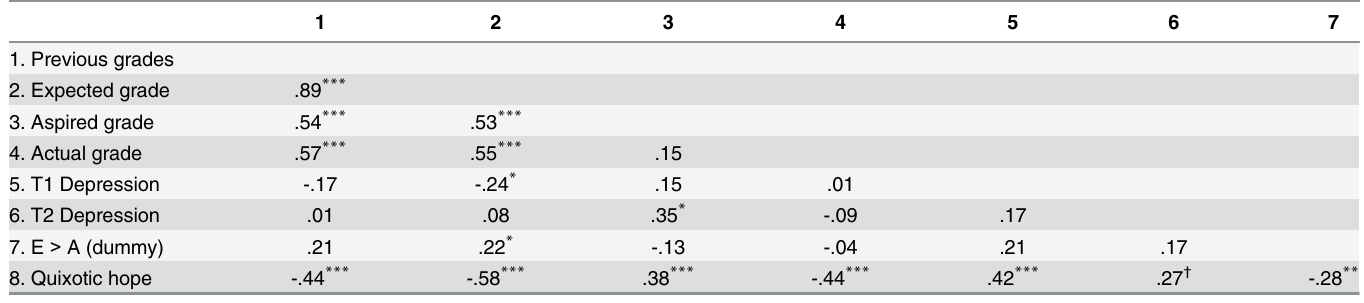
Table 2. Bivariate correlations between the variables in the model (Study 1).